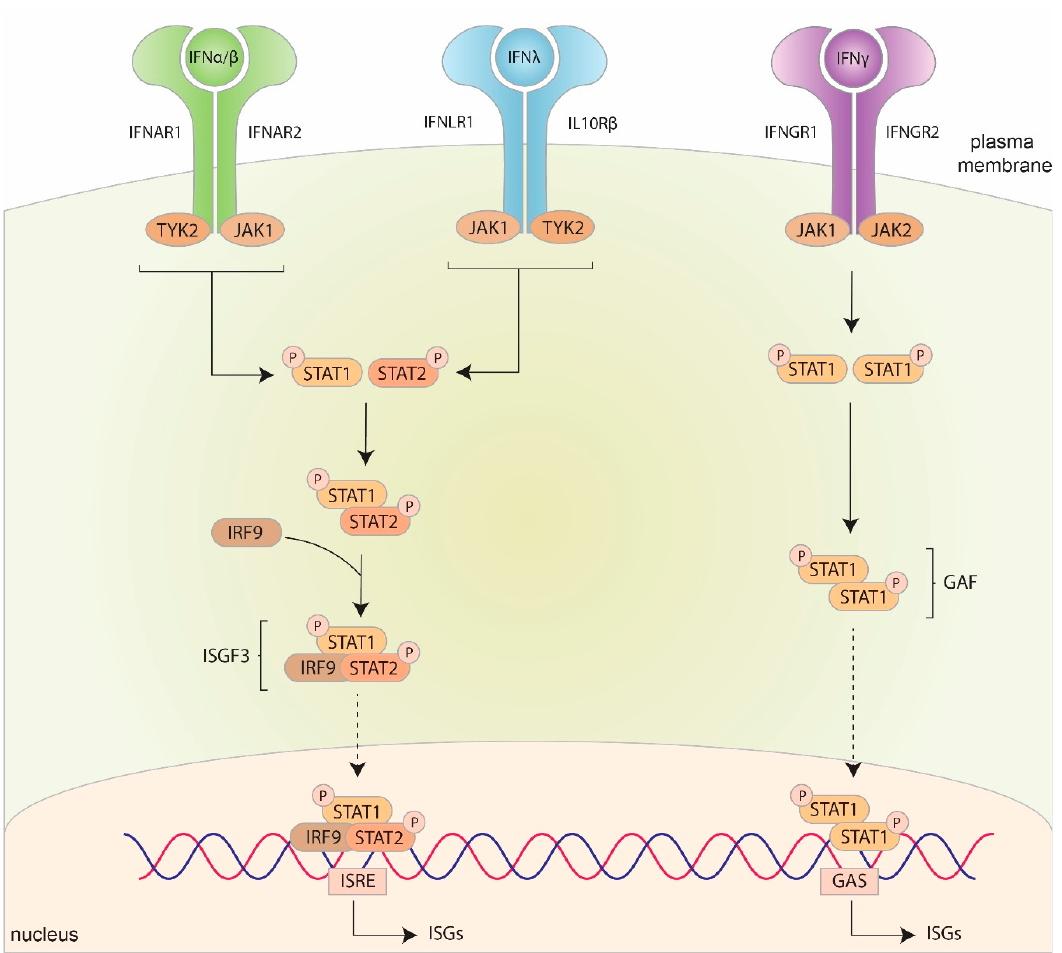
Figure 3. Canonical signaling pathways of interferon (IFN). The binding of type I IFNs to interferon- α receptor (IFNAR) and type III IFNs to interferon- λ receptor (IFNLR) results in the activation of Janus kinase 1 (JAK1) and tyrosine kinase 2 (TYK2) resulting in the phosphorylation of signal transducers and activators of transcription (STAT) 1 and 2. STAT1 and STAT2 interact with interferon regulatory factor (IRF) 9 to form the complex IFN-stimulated gene factor 3 (ISGF3), which translocates to the nucleus to bind to interferon-stimulated response element (ISRE) to induce the expression of ISGs. The binding of type II IFN to interferon- γ receptor (IFNGR) results in the activation of JAK1 and JAK2 resulting in the phosphorylation of STAT1. STAT1 then forms a STAT1-STAT1 homodimer, also known as gamma interferon activation factor (GAF), which translocates to the nucleus to bind to gamma interferon activated sites (GAS) to induce the expression of ISGs. Solid lines represent downstream activation, dashed lines represent translocation.